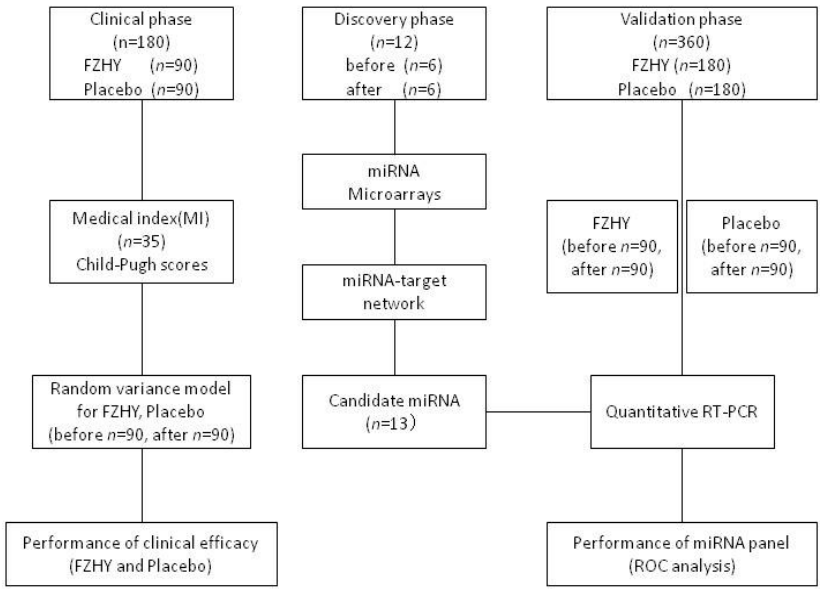
Figure 6. Overview of the framework. FZHY: Fuzheng-Huayu (Chinese herbal formula); MI: medical index; RT-PCR: reverse transcriptase polymerase chain reaction; ROC: receiver operating characteristic.